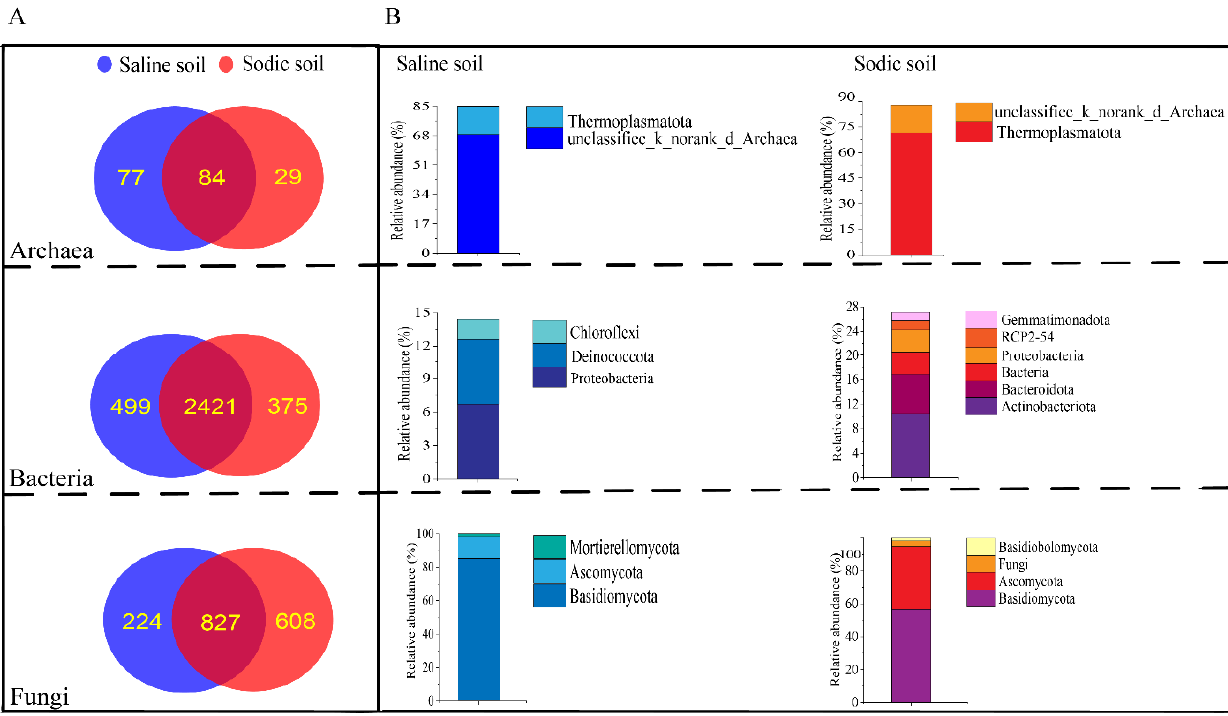
Figure 2. ( A ) Venn diagrams of archaeal, bacterial, and fungal OTUs. ( B ) Unique OTUs of archaea, bacteria, and fungi belonging to different phyla.